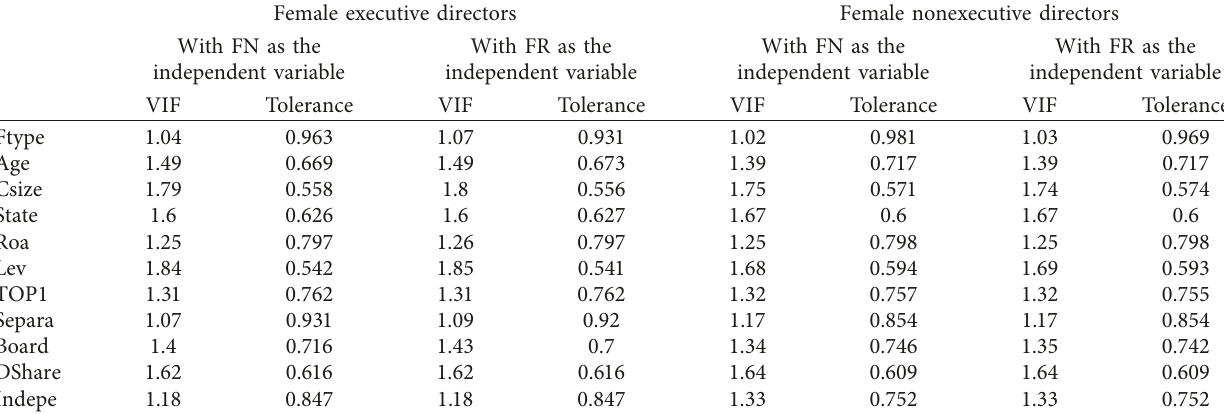
Table 9: Test results of variance inflation factor of regression models for different types of FDs.